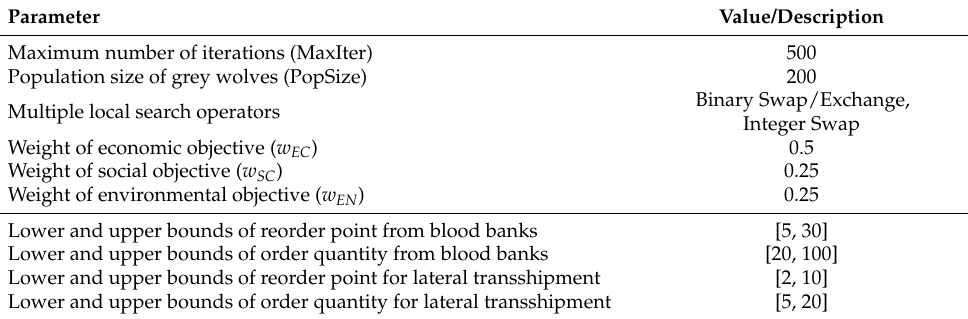
Table 2. Parameters of the LSGWO algorithm.